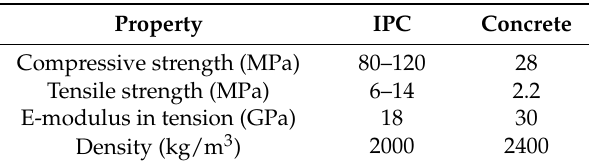
Table 6. Material properties of IPC and concrete [25].